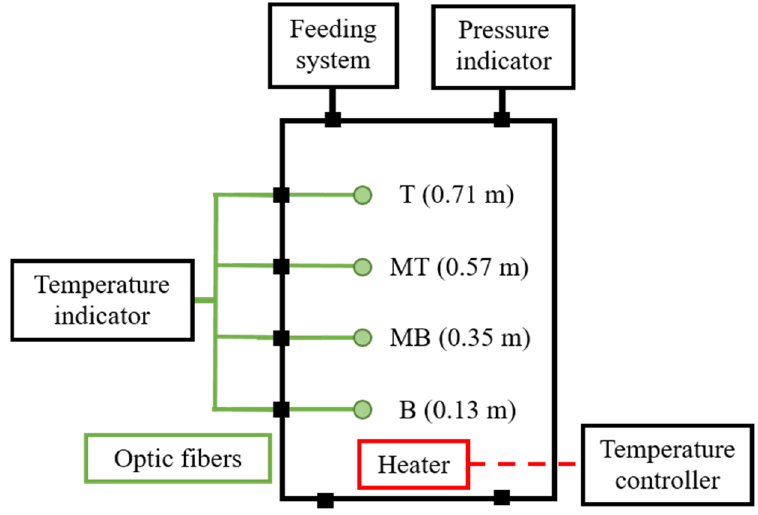
Figure 1. Scheme of the experimental equipment used for the monitoring of the temperature .